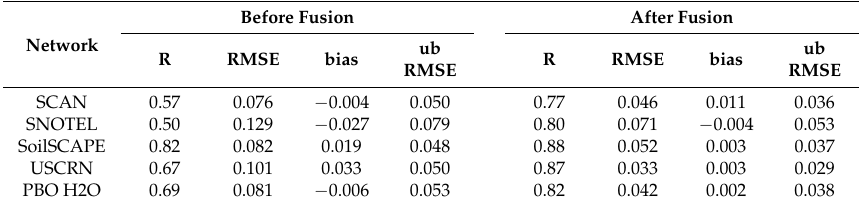
Table 3. Performance of the GRNN model on each network using “sm_sat-whole”. Before Network